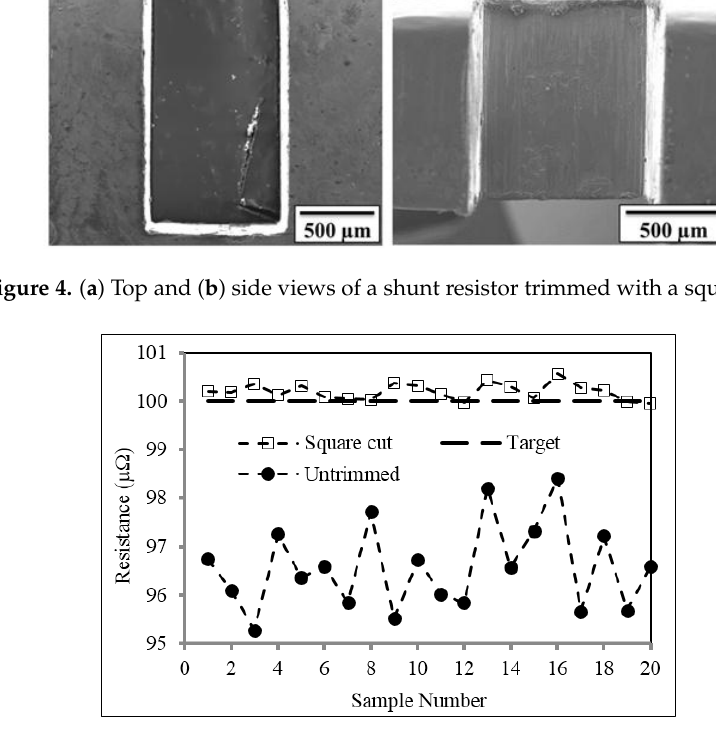
Figure 5. Resistance values of the shunt resistors before (untrimmed) and after trimming with the square cut.